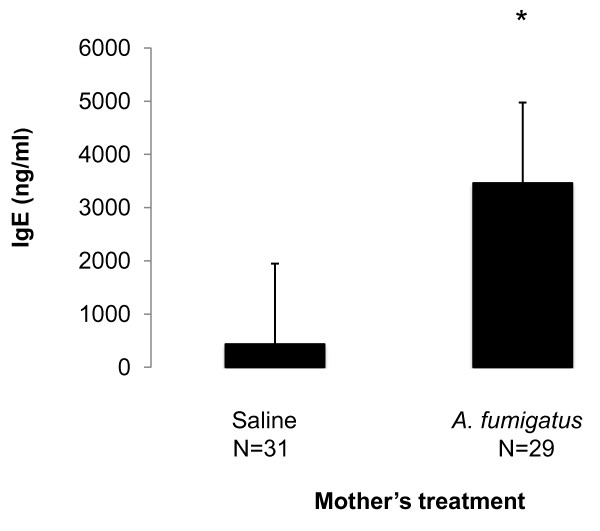
IgE levels following sensitization of mothers to A. fumigatus. IgE levels were measured in adult females after 5 doses of A. fumigatus and immediately prior to mating. *p < 0.0001, two tailed Mann-Whitney test